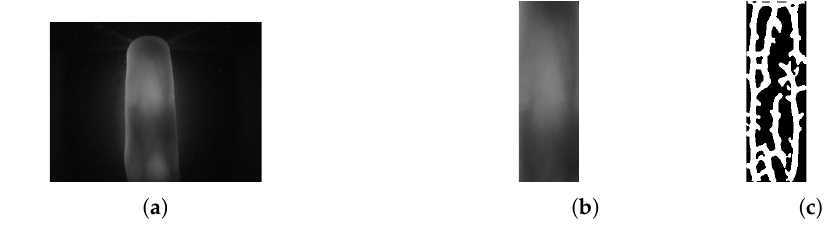
Figure 9. The preprocessing results. ( a ) original finger-vein image from FV-USM. database; ( b ) ROI image from ( a ); ( c ) vein feature from ( b